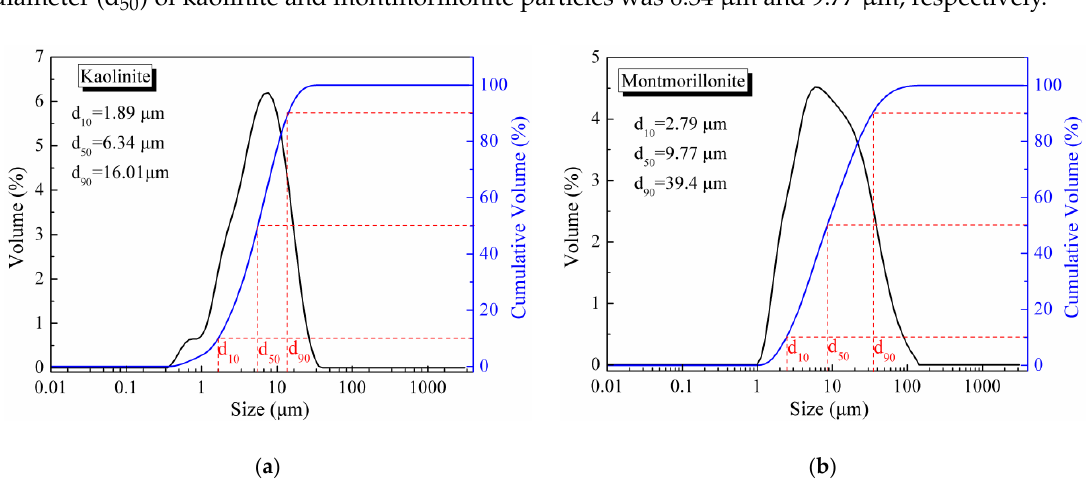
Figure 1. Particle size distribution of ( a ) kaolinite and ( b ) montmorillonite.